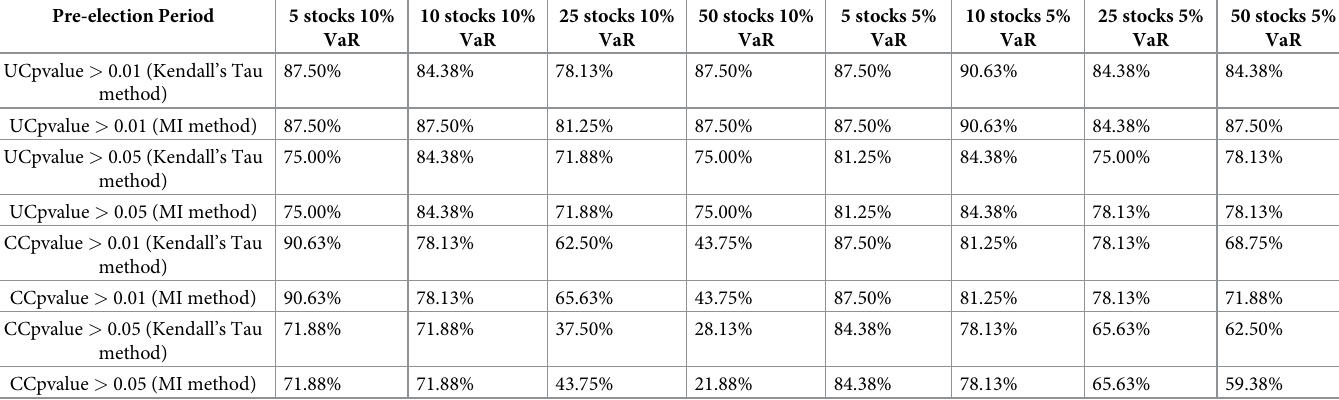
Table 1. Unconditional (UC) and conditional (CC) coverage tests at 1% and 5% level of significance: Pre-election period.